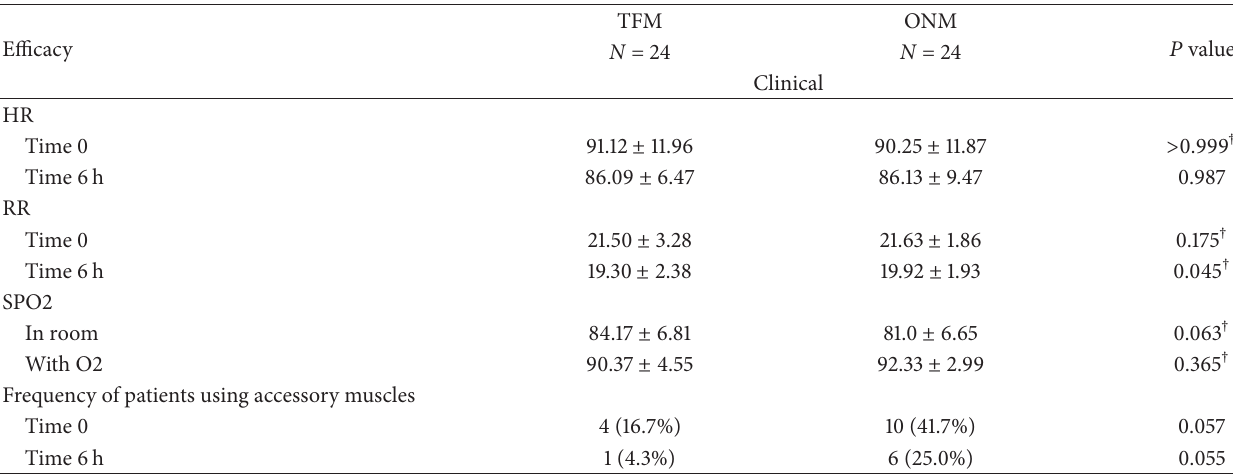
Table 2: Comparison of clinical and oxygenation parameters at baseline (time zero) and six hours after initiation of treatment.